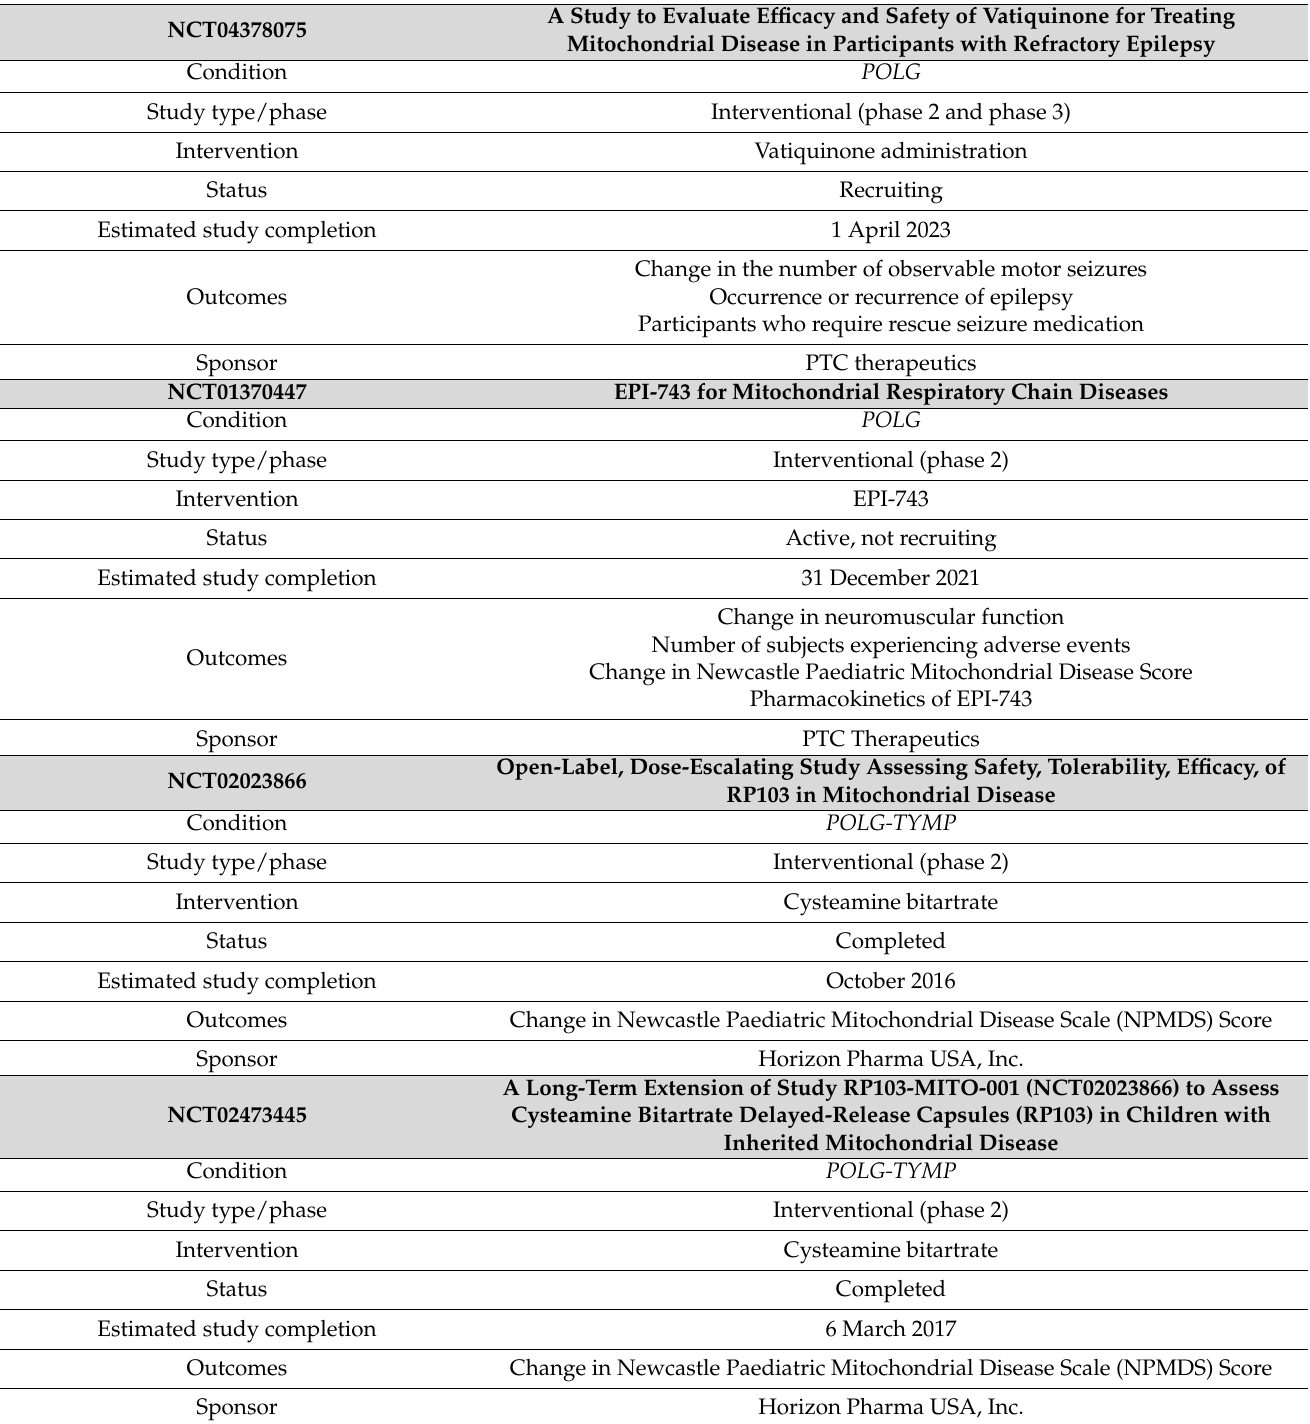
Table 2. Clinical trials recruiting patients with mitochondrial DNA replication disorders. Only ongoing or recently conducted clinical trials accepting patients with MDDS are